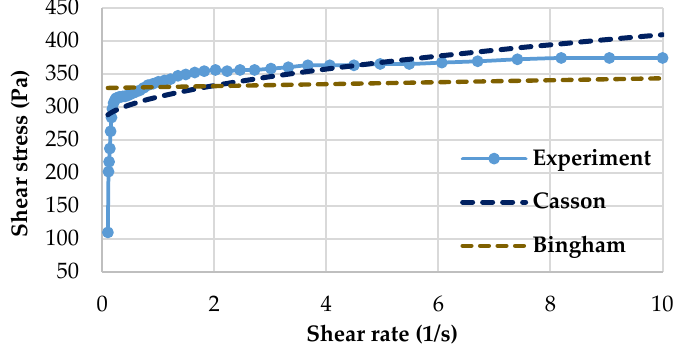
Figure 5. Flow curve for Sample S4-I with Casson and Bingham curve fitting models.